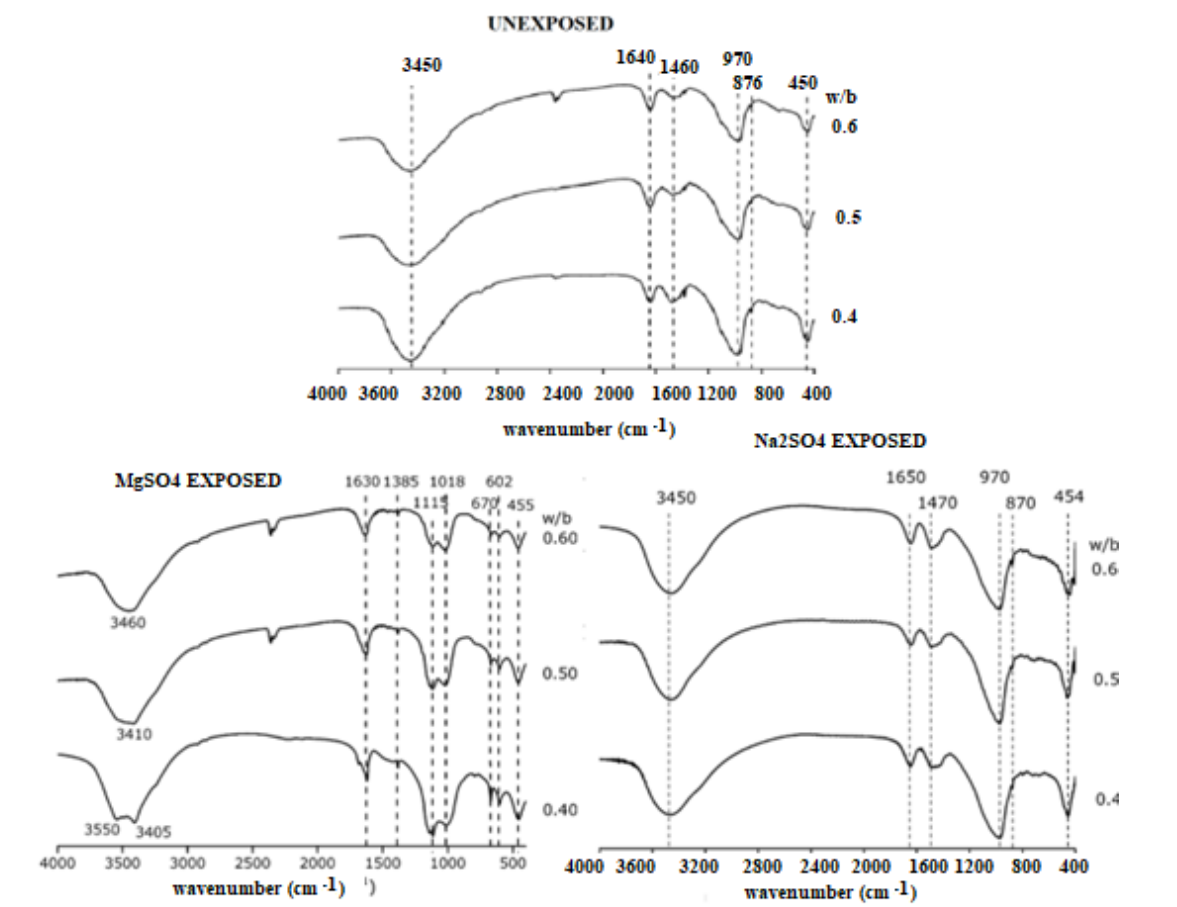
Figure 13. Effect of a sulfate attack on a Si-O-T band (From RILEM Ref. [66] and used with permission).